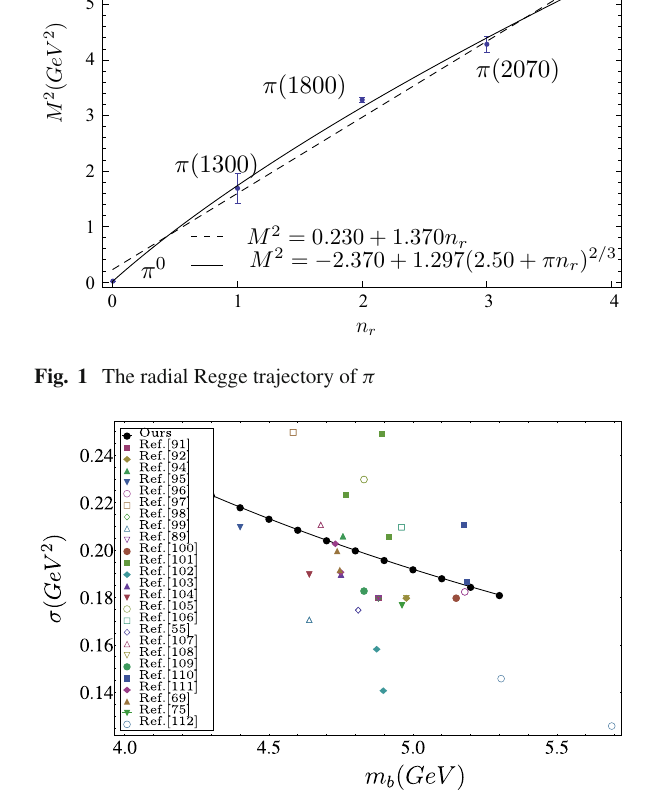
Fig. 2 Choice of parameters for various models incorporating the lin- ear potential or the screened linear potential. The joined black line (Ours) is for σ = β 3 / 2 /( 12 m b ) ( β = 5 . 1 GeV 2 ) which is from